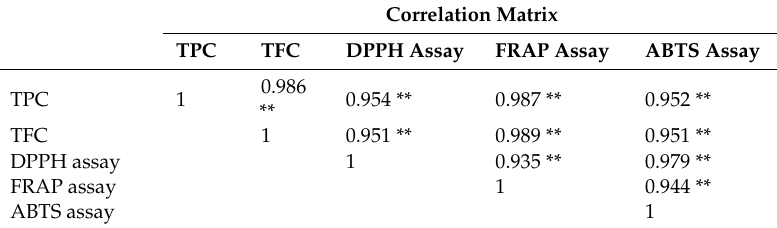
Table 1. Correlation matrix of TPC, TPC, and TAA in ZAV during the brewing process 1, 2 .